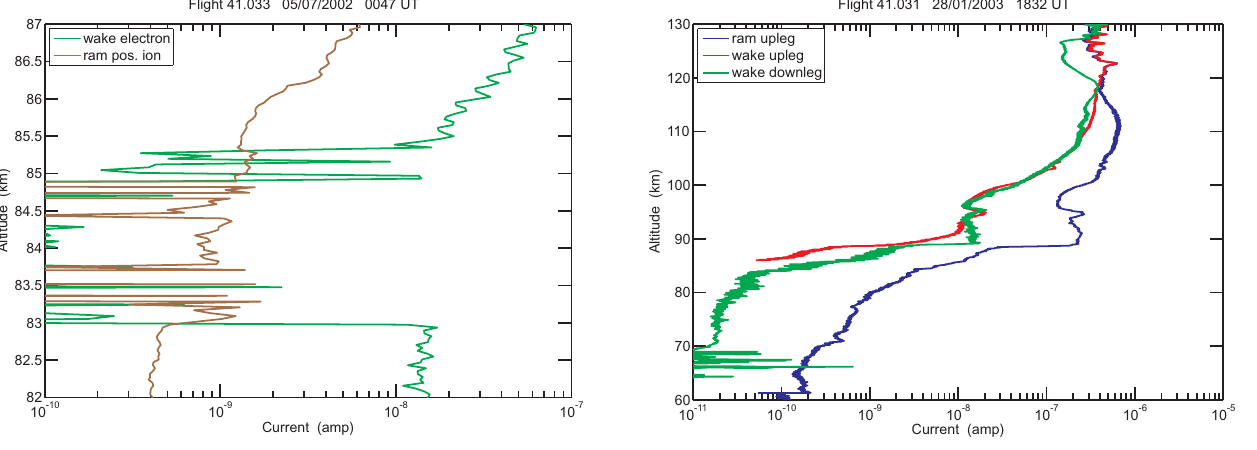
Fig. 16. Comparison of electron current measurements for Flight 41.031 (28 January 2003, 18:32 UT).